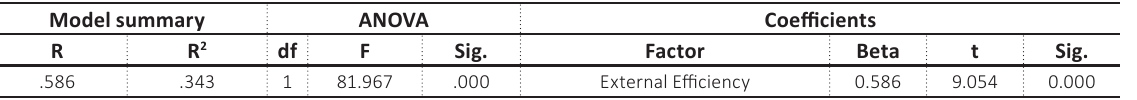
Table 11. Simple linear regression results for H01.3 Model summary